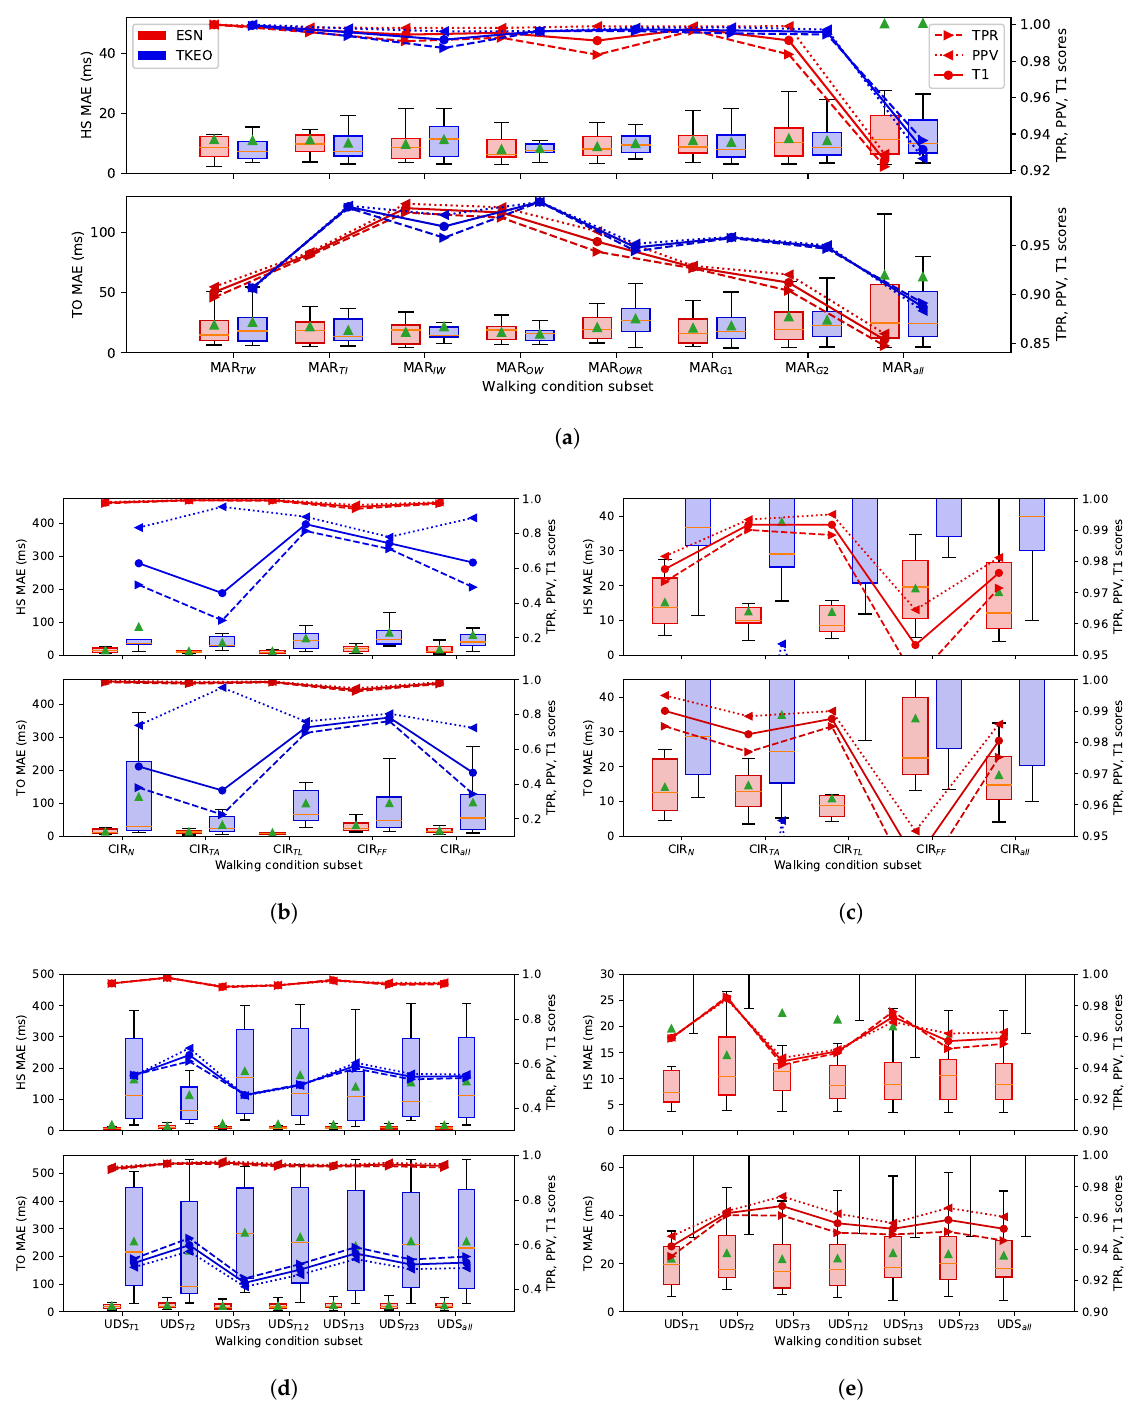
Figure A3. MAE, TPR, PPV and T1 comparison between the ESN and TKEO algorithms for HS and TO events for multiple walking condition subsets. ( a ) MAREA database; ( b ) CIRRIS database; ( c ) CIRRIS database (zoom on ESN results); ( d ) UDS database; ( e ) UDS database (zoom on ESN